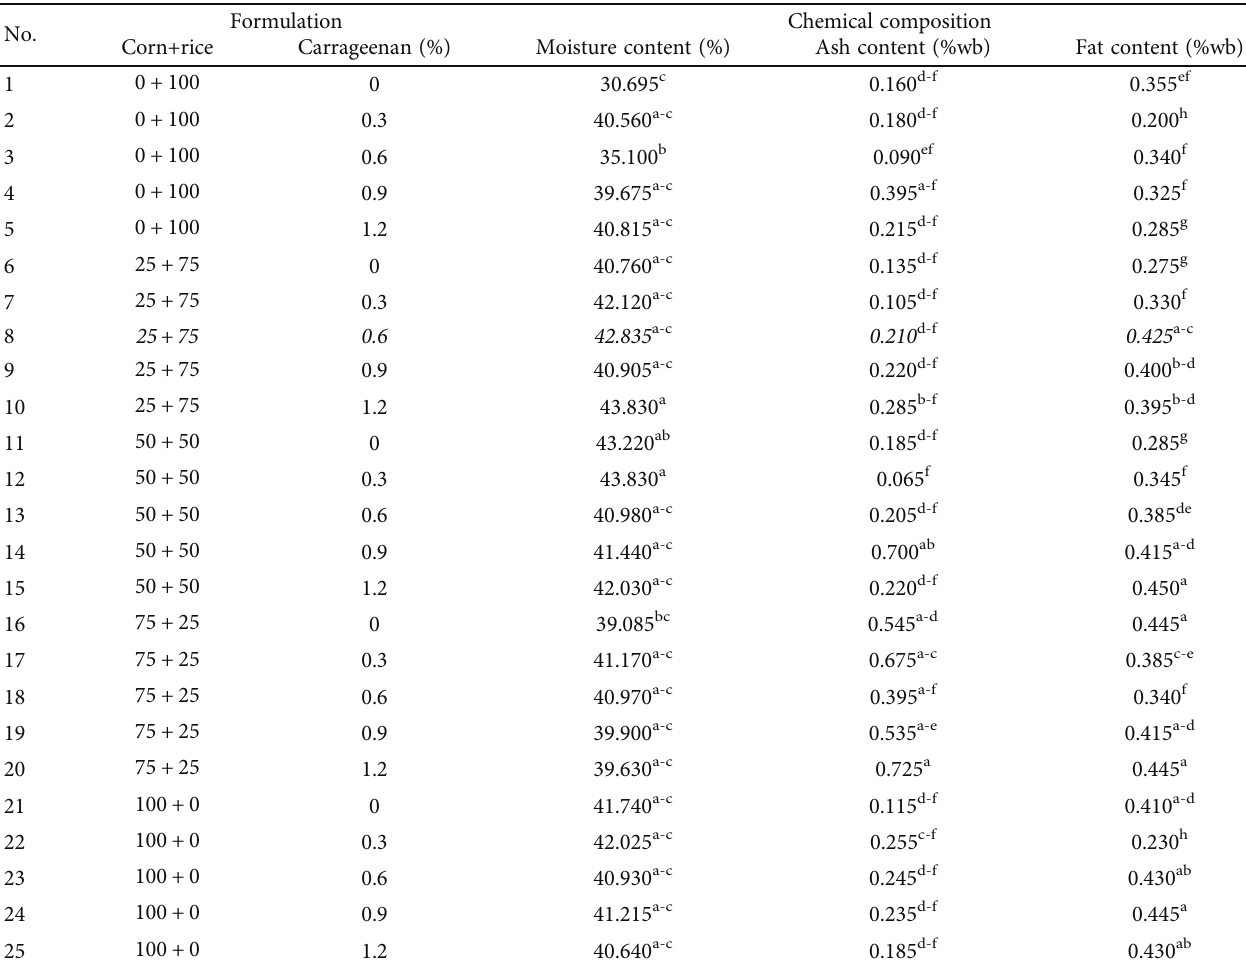
Table 2: Chemical composition of vermicelli from mixed with corn and rice fl our, with the addition of carrageenan.